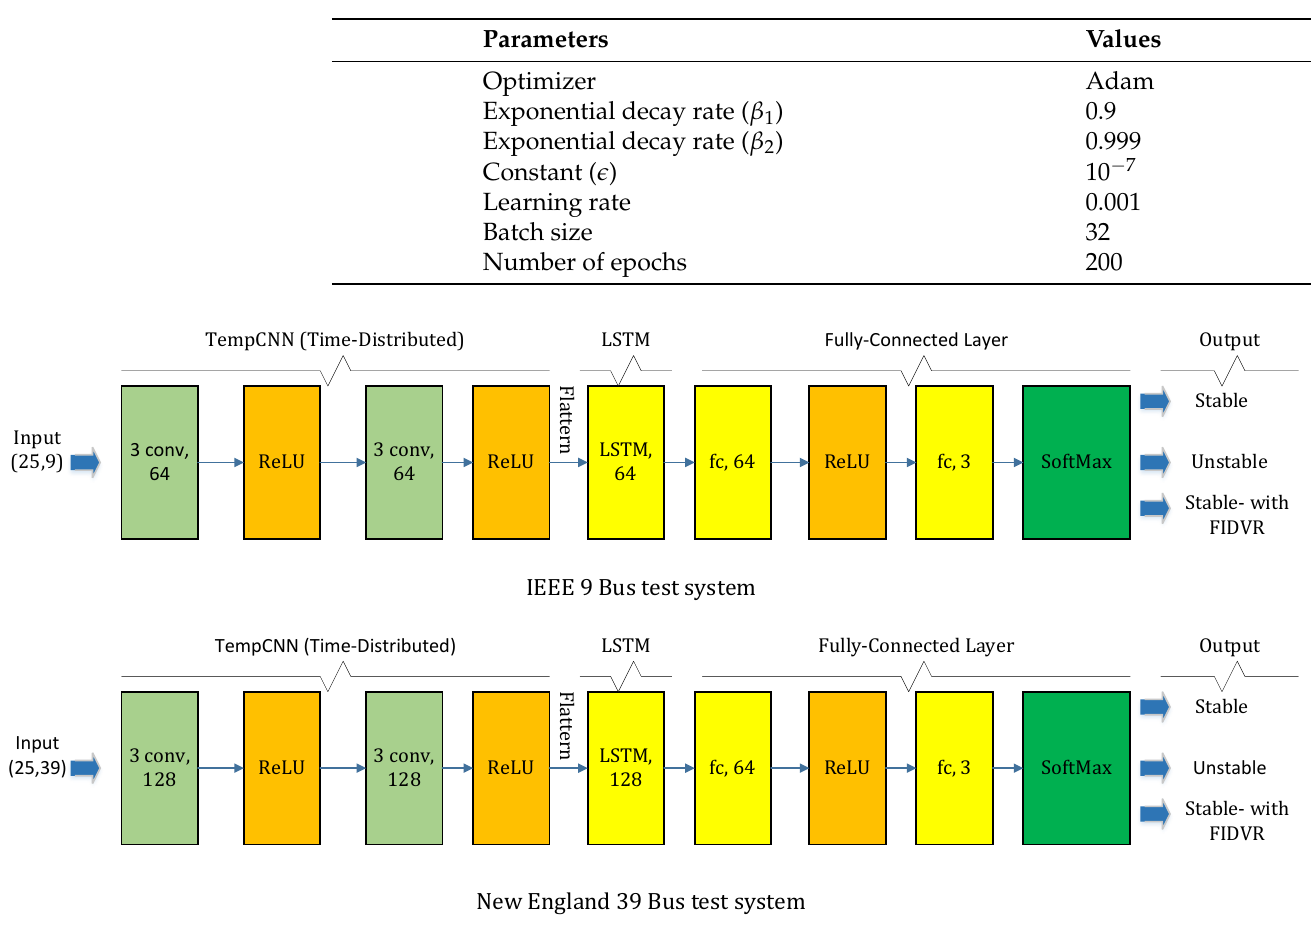
Table 4. Parameter settings of the proposed TempCNN-LSTM model on test systems.